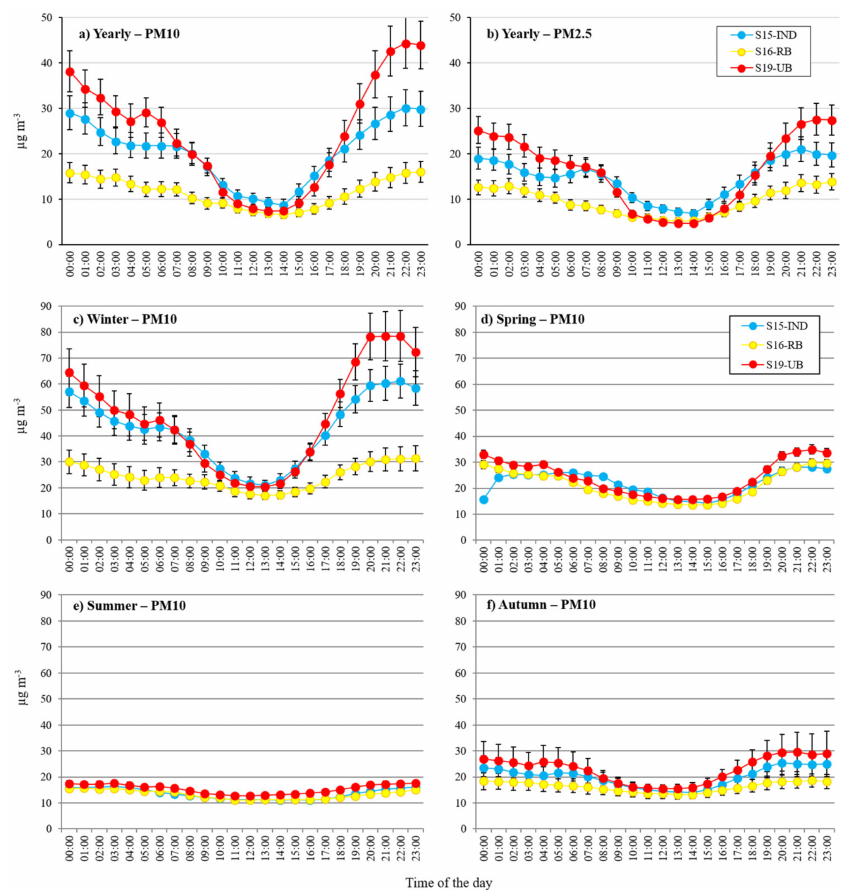
Figure 3. Annual and seasonal daily cycles observed by the S15-IND, S16-RB, and S19-UB stations across the whole study period: ( a , b ) yearly cycle of PM 10 and PM 2.5 concentrations; ( c – f ) seasonal cycle of PM 10